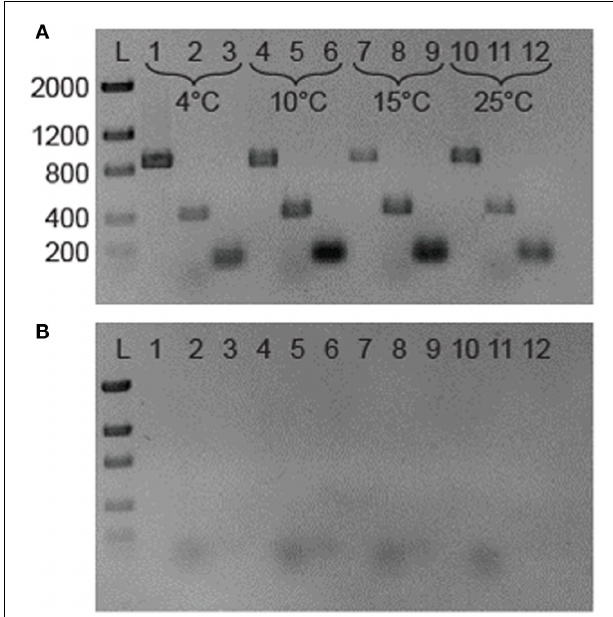
FIGURE 2 | (A) Reverse transcription-PCR analysis of gene expression in 3519-10.The 876-bp bands in lanes 1, 4, 7, and 10 represents the presence of 16S rRNA; the 421 and 100bp bands are fragments of RT-PCR IBP and cspA transcripts, respectively.The template for lanes 1–3 was RNA from a 4˚C grown culture of 3519-10, 4–6 from 10˚C, 7–9 from 15˚C, and 10–12 from 25˚C cultures. (B) . Identical samples lacking a RT step. Lane assignments are the same as for (A) . L is a low DNA mass ladder